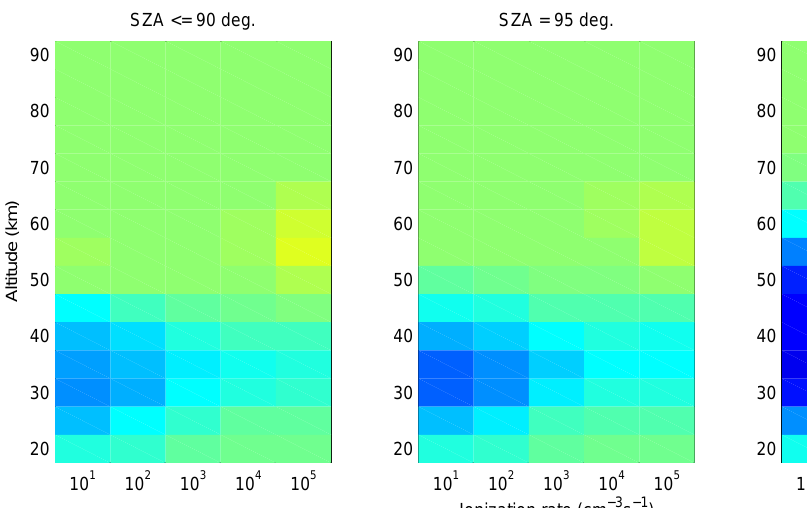
/Q for October 2